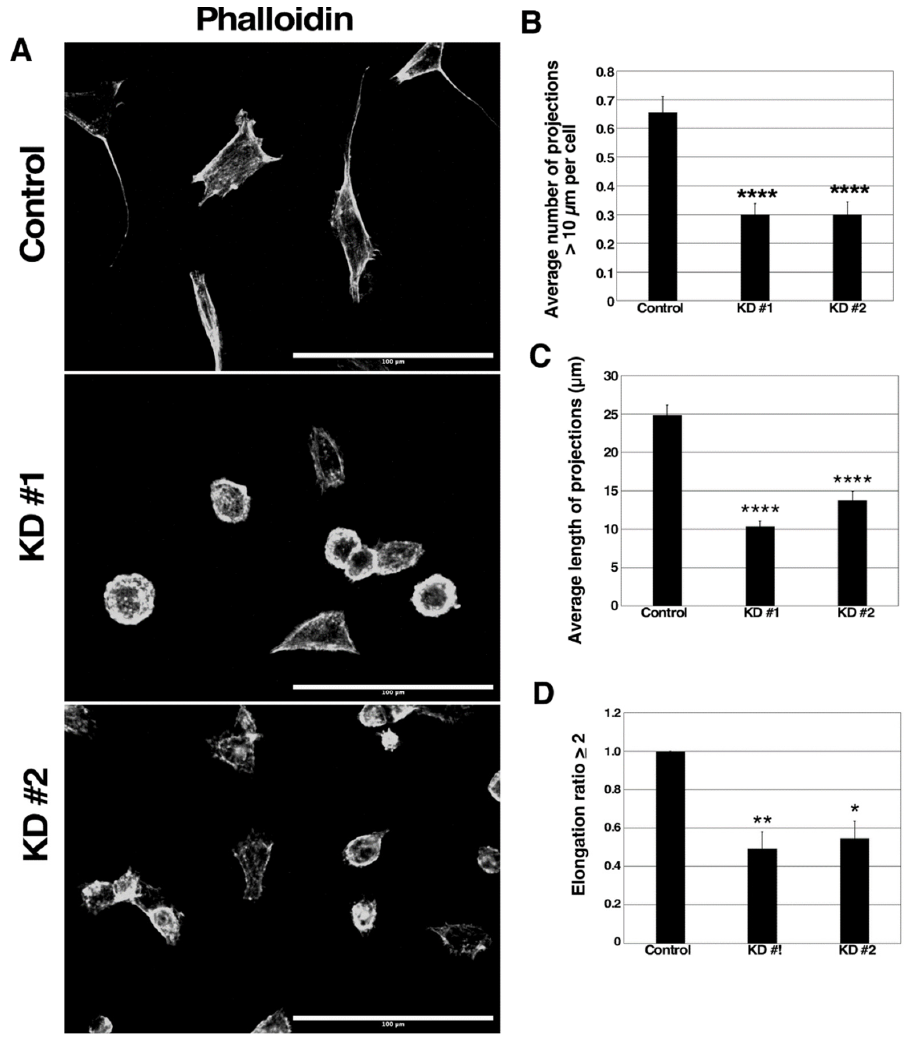
Figure 5. mGBP-2 alters the morphology of 67NR cells in vitro. ( A ). Control, KD #1, and KD #2 67NR cells were serum starved for 3 h. Cells were then incubated with warm 20% FBS in DMEM for 30 min. Cells were fixed, permeabilized, stained with Alexa fluor 594 phalloidin and 150 nM DAPI. Random fields were imaged on an EVOS FL Inverted Microscope at 40X using DAPI and Texas Red filters. Representative images are shown (Scale bars = 100 μ m). ( B ). The number of projections of 100 control, KD #1, and KD #2 67NR cells were counted. The graph represents the average number of projections per cell + SEM (****, p < 0.0001 compared to control cells, n = 3). ( C ). The length of projections of 100 control, KD #1, and KD #2 67NR cells were measured. The graph represents the average length of projections per cell + SEM (****, p < 0.0001 compared to control cells, n = 3). ( D ). The elongation ratios of 100 control, KD #1, and KD #2 67NR cells were measured. The graph depicts the average percentage of cells with an elongation >2 + SEM (*, p < 0.05; **, p < 0.01 compared to control cells, n = 3).